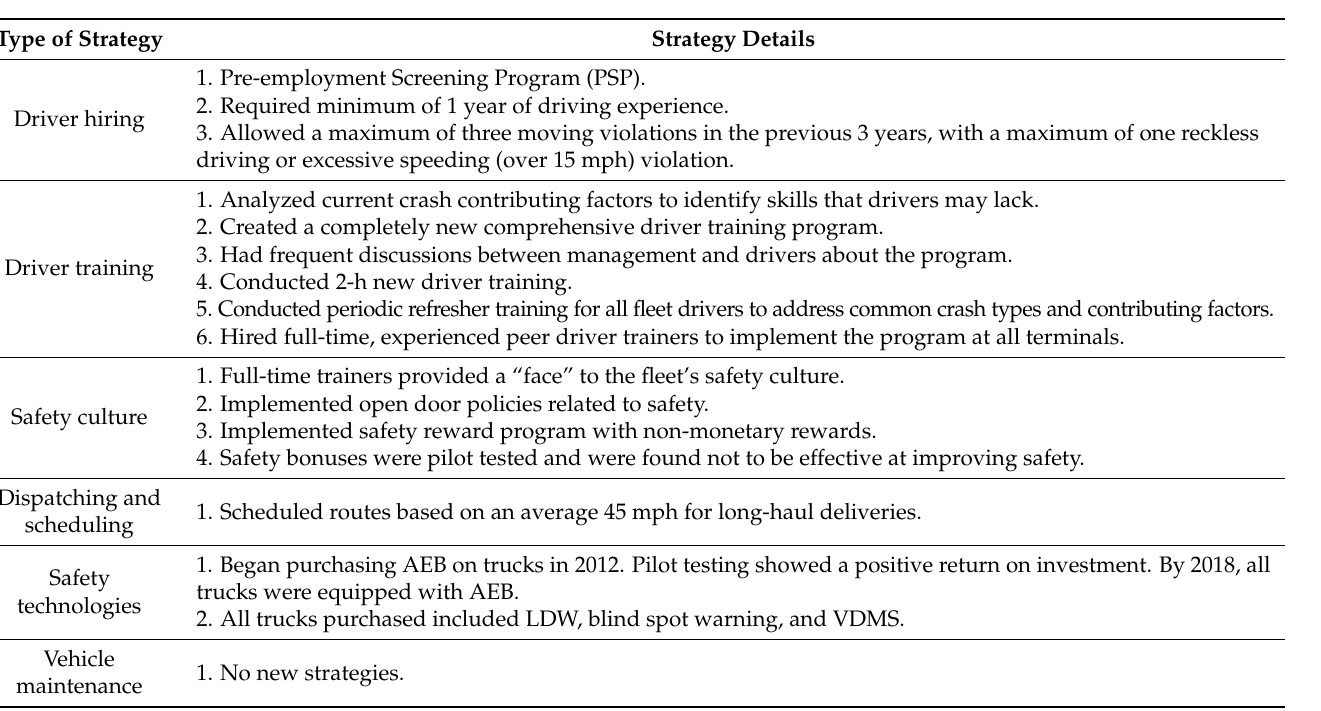
Table 3. Fleet A’s safety improvement